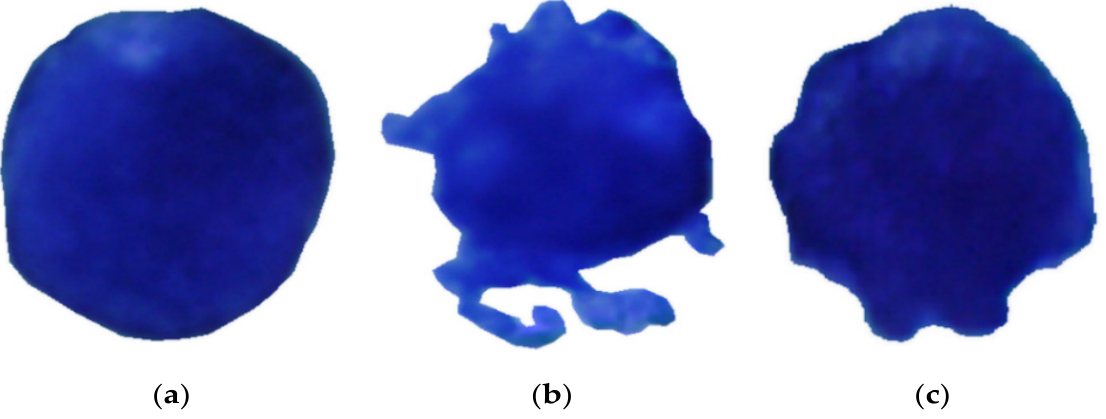
Figure 1. Illustration of morphological modifications during DC maturation. Immature DC ( a ) has a round shape without cytoplasmic expansions, while its more complicated and irregular shape distinguishes mature DC ( b ) with longer and finer dendrites. The morphology of dendrites changes in the presence of a toxic substance. The inhibited cell ( c ) is different from mature cells. It presents fewer and shorter extensions that appear closed with each other and smaller in size than those seen on mature cells.